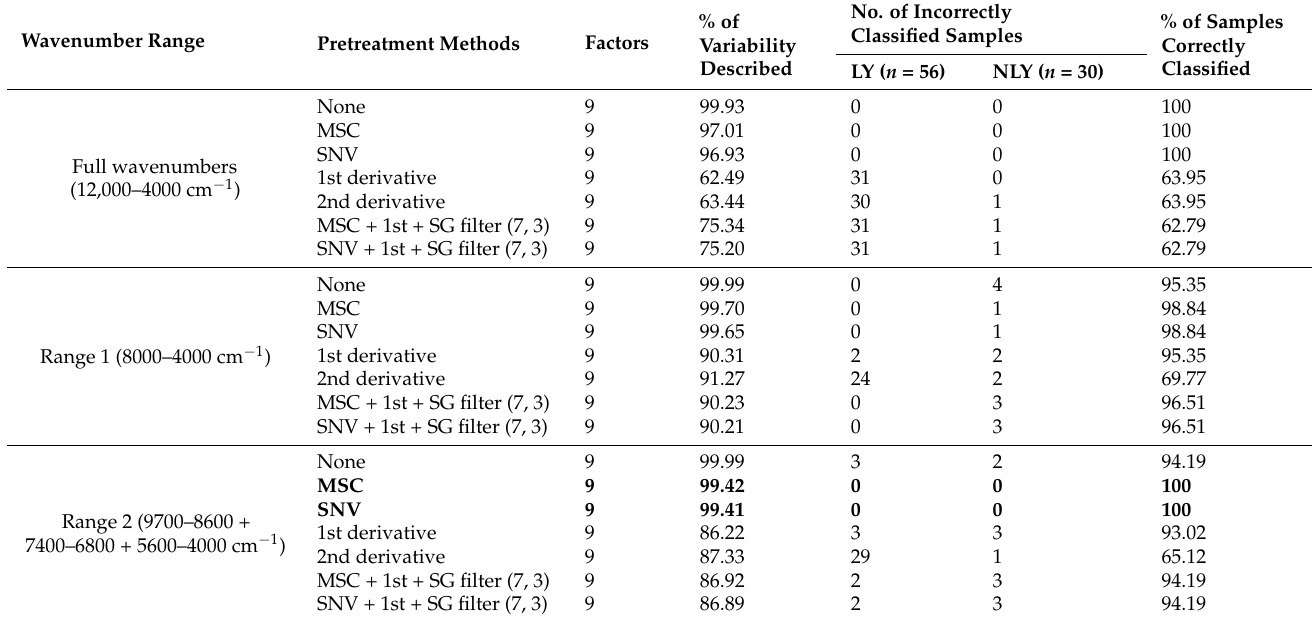
Table 1. Performance of DA models with different spectral preprocessing